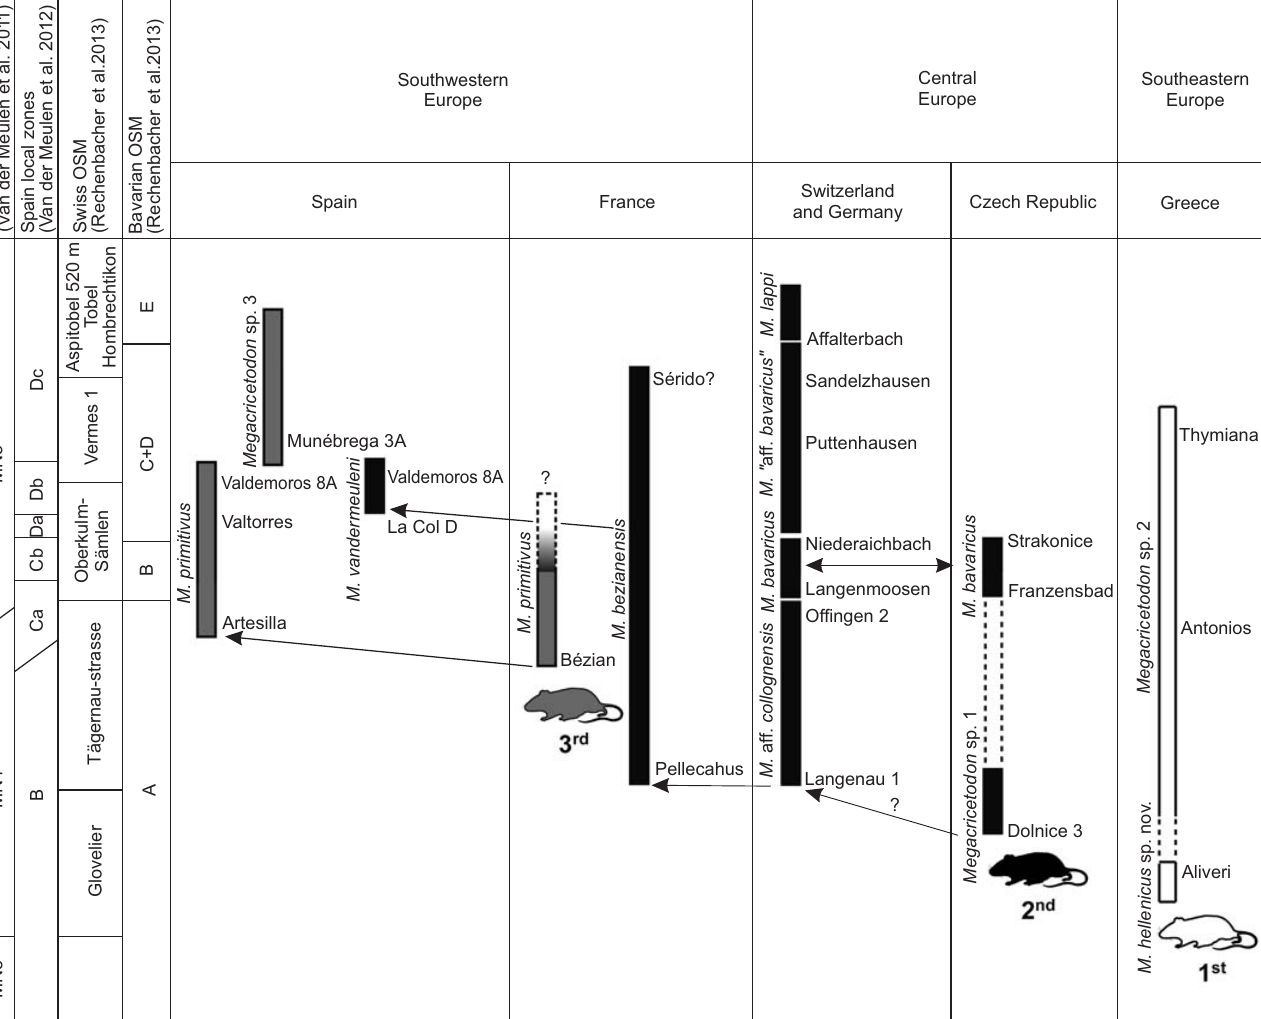
Fig. 4. Biostratigraphic distribution of Early Miocene Megacricetodon species from Europe with indication of the proposed migrations events among South-eastern Europe (Greece), Central Europe (Czech Republic, Switzerland, and Germany) and South-western Europe (France and Spain), modified from Oliver and Peláez-Campomanes (2013). The silhouettes of the cricetid indicate indicate three phases of immigration of Megacricetodon species into